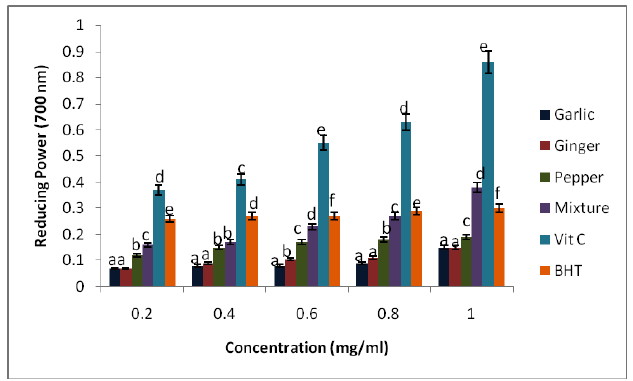
Fig. 1: Reducing power of aqueous extracts of garlic, ginger, pepper and their mixture. a-f Values are means of 3 determinations ± SEM. Bars with different colours carrying different letters are significantly different (P<0.05). Vit. C = vitamin C, BHT = butylated hydroxyl anisole (standards).